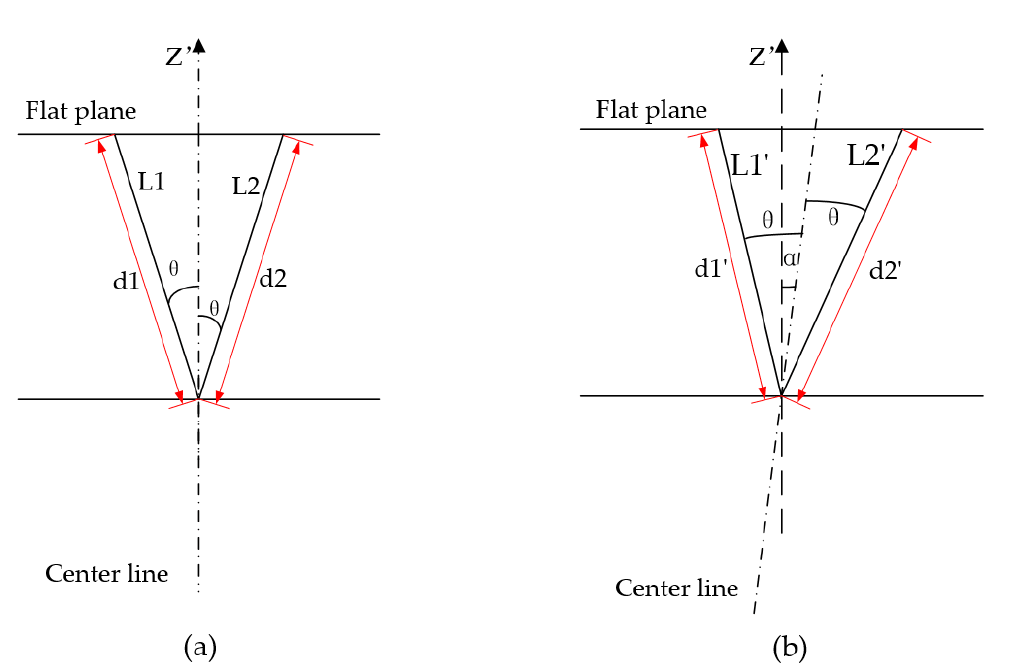
Figure 6. Geometrical relationship of calculating the bias angle. ( a ) denotes the centerline coincides with the Z (cid:48) axis of X (cid:48) Y (cid:48) Z (cid:48) coordinate system; ( b ) denotes the centerline deviates an angle α from Z (cid:48) axis.